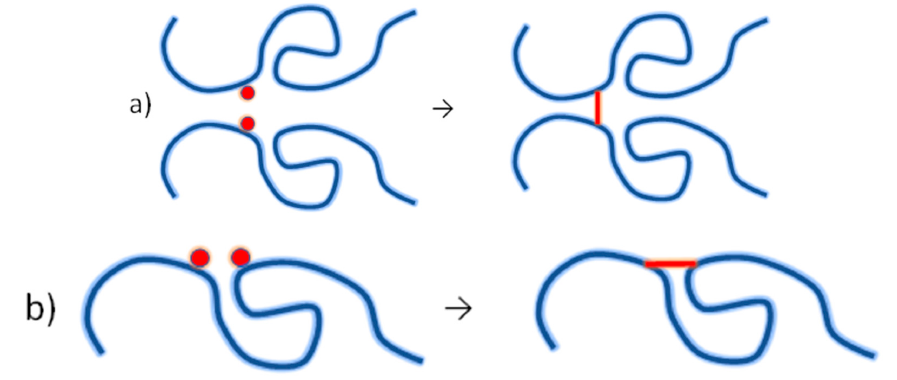
Figure 21. Crosslinking by recombination of two polymer radicals: ( a ) intermolecular, ( b ) intramolecular.